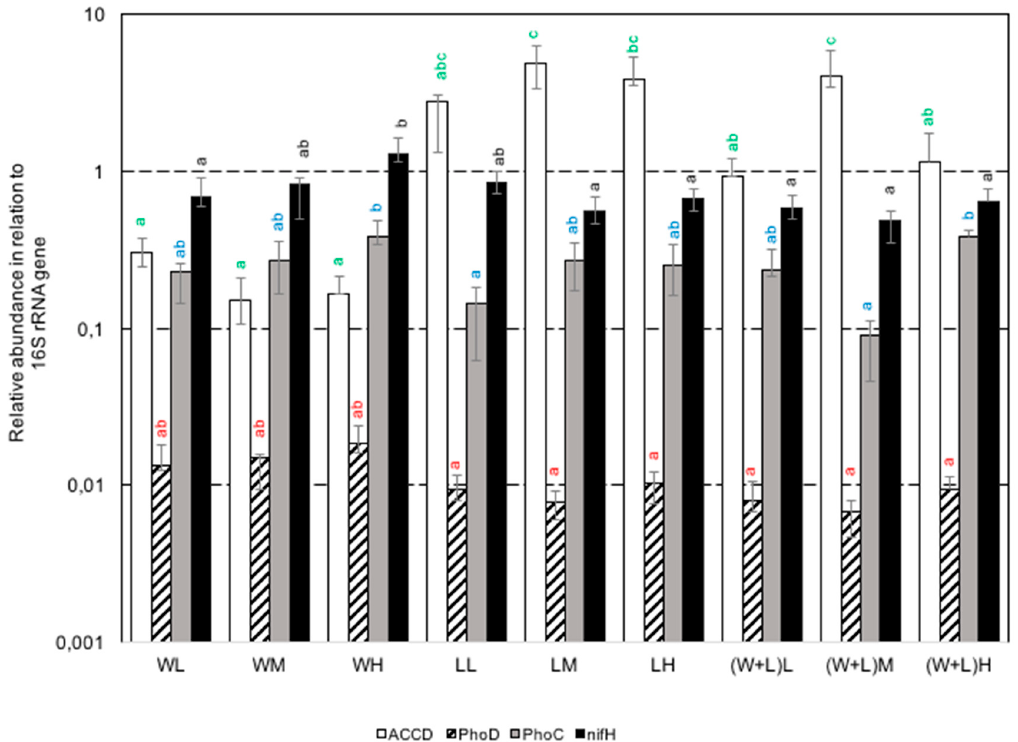
Figure 2. Relative abundance of functional genes in relation to the16S rRNA gene determined by quantitative PCR (qPCR). acd S: 1-aminocyclopropane-l-carboxylate deaminase (ACCD); pho D: alkaline phosphomonoesterease, pho C: non-specific acid phosphomonoesterase; nif H: N 2 fixation. Error bars represent the standard error. Different letters of the same color indicate significant differences according to Duncan test ( P < 0.05). WL: wheat at low plant density (PD); WM: wheat at medium PD; WH: wheat at high PD; LL: lupin at low PD; LM: lupin at medium PD; LH: lupin at high SD; (W + L)L: intercropping at low PD; (W + L)M: intercropping at medium PD and (W + L)H: intercropping at high PD.